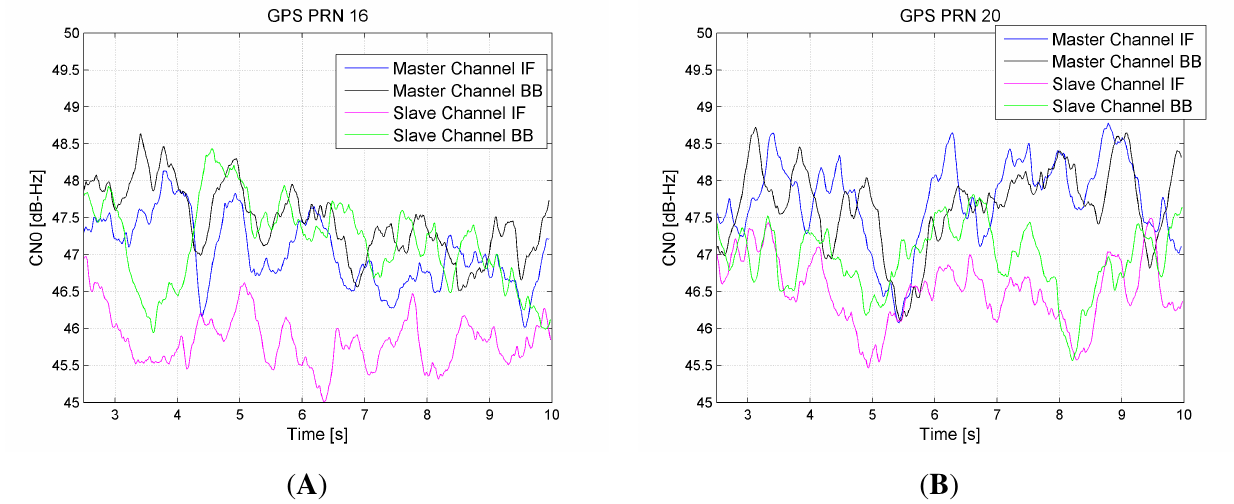
Figure 6. C/N evaluation for PRN16 ( A ) and PRN 20 ( B ), obtained during a test in a 0 simulated